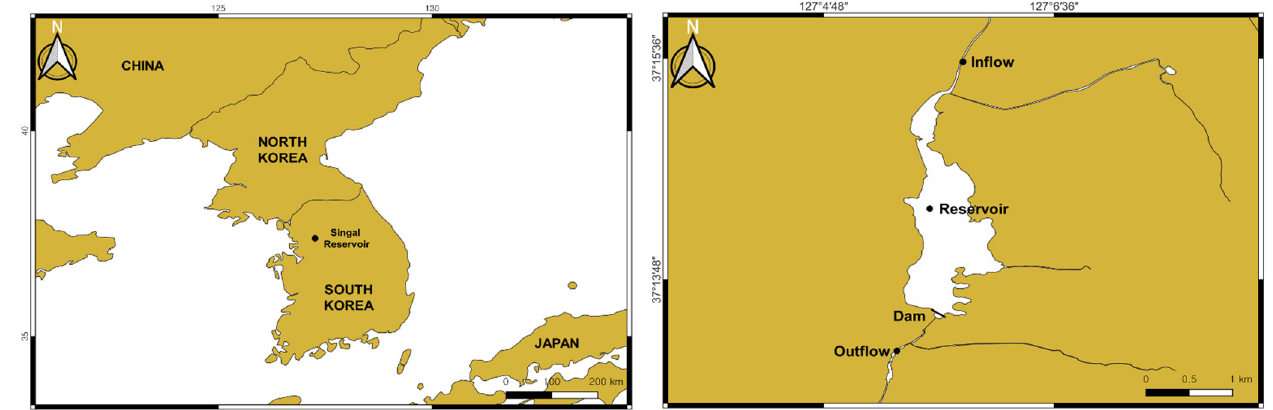
Figure 1. Map of the study sites in Singal reservoir. Inflow and outflow are the stream sites connected with Singal reservoir.